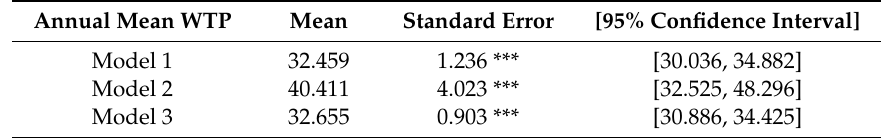
Table 3. Estimation results of the double-bounded